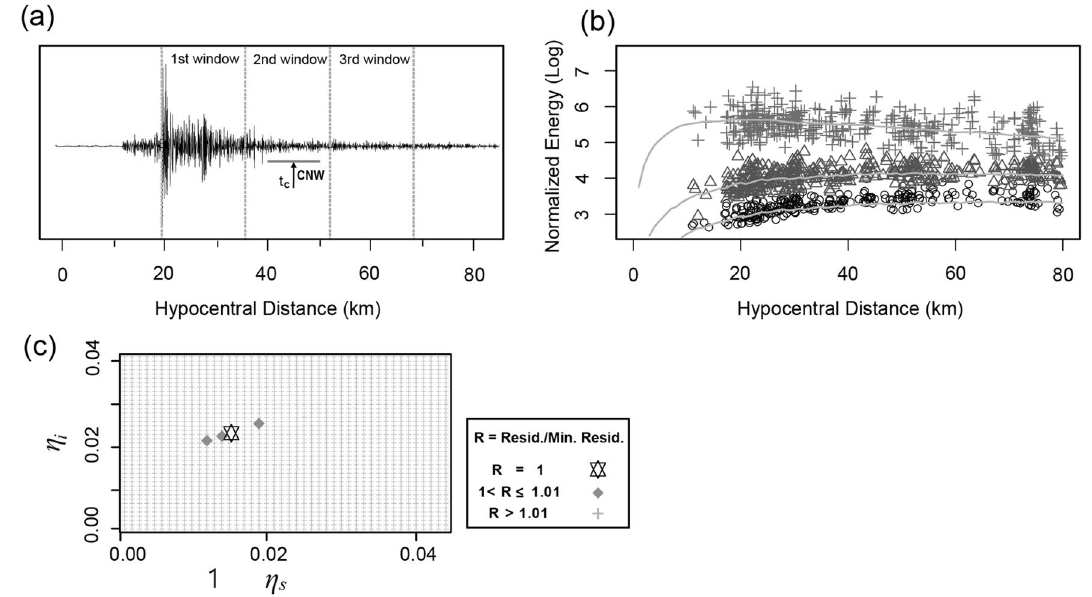
Figure 8. (a) Example of seismogram (N–S component) used for multiple lapse time window analysis (MLTWA) showing three-time windows (0–15 s, 15–30 s, and 30–45 s) starting at the arrival of S -waves. The time bar with 10 s denotes the coda normalization window (CNW). Its center ( t c ) denotes a fixed reference time (45 s lapse time). ( b ) Example of a MLTWA fit of the normalized energy recorded of the Kumamoto earthquake in the 1–2 Hz frequency band. The theoretical curves based on the plus signs, triangles, and circles obtained from the first, second, and third windows in the left diagram, respectively, were fitted using Monte Carlo simulations 33 . ( c ) Residual map corresponding to (b). The areas normalized by the minimum residual value (star), = M f 1.01, are plotted with dark rhombuses as the F test confidence zone at the 60%